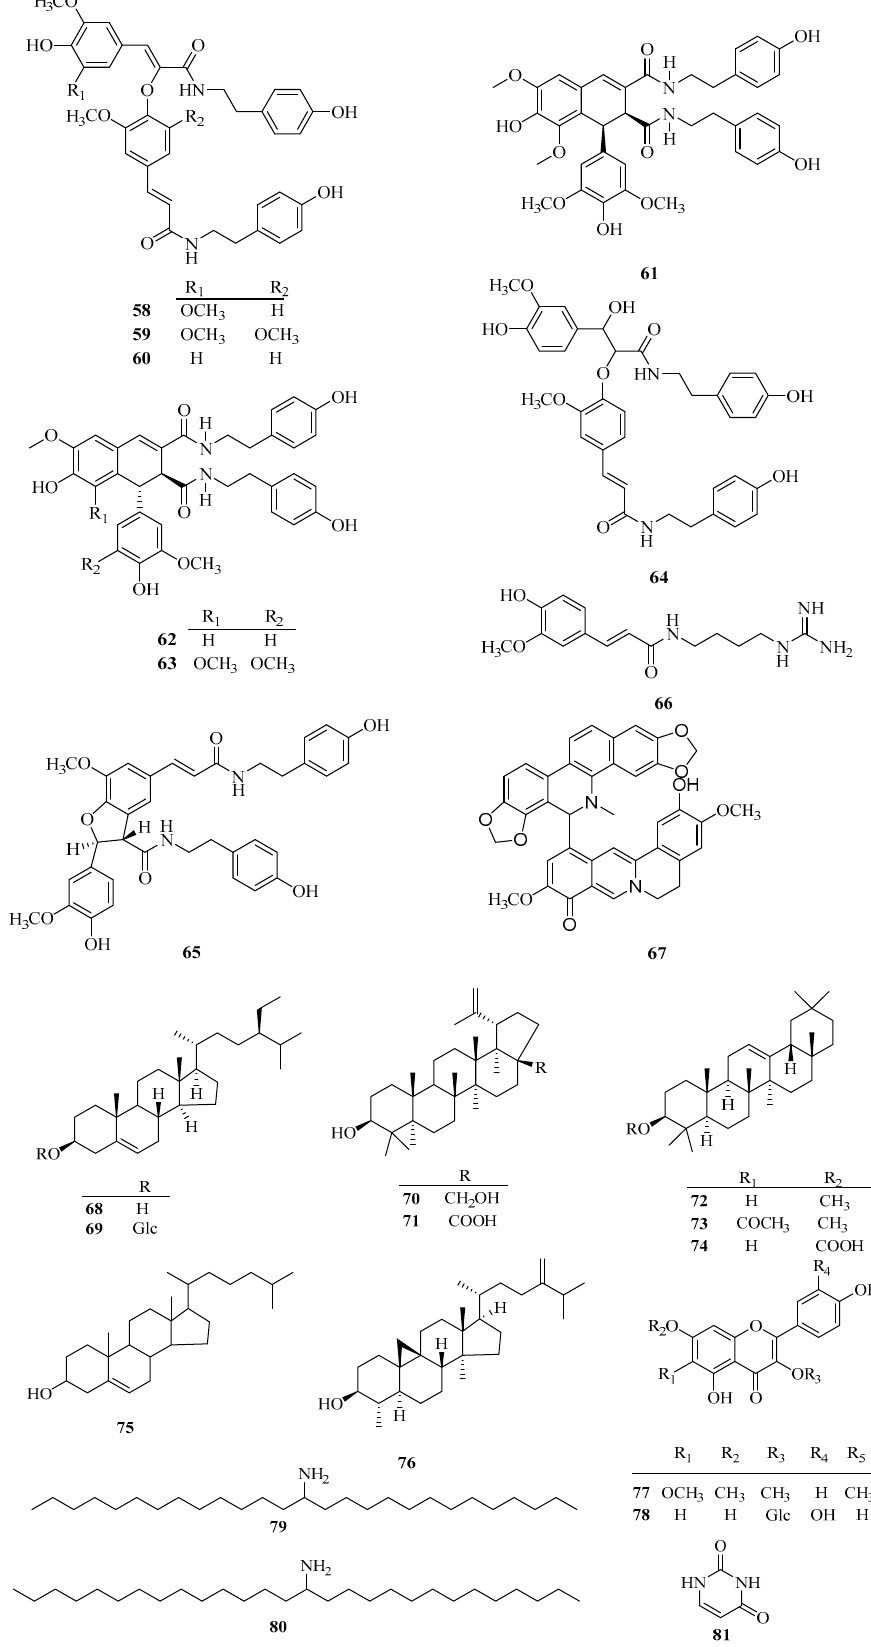
Figure 2. Chemical structures isolated from Corydalis saxicola Bunting.